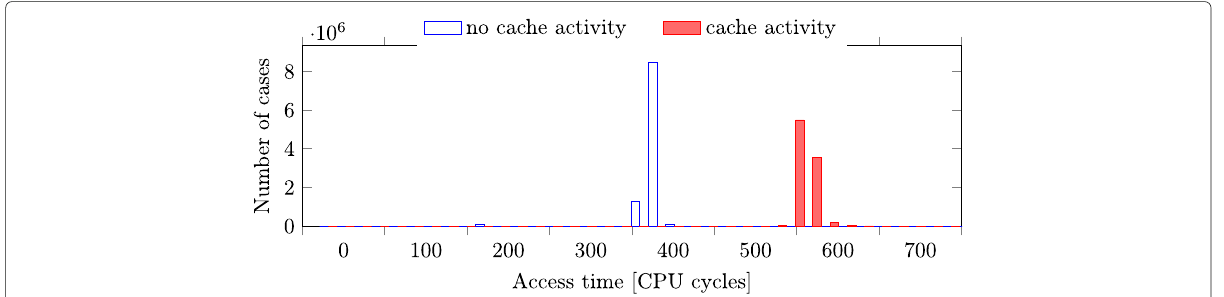
Fig. 5 Histogram showing the runtime of the prime step for cache activity in the same set and no cache activity in the same